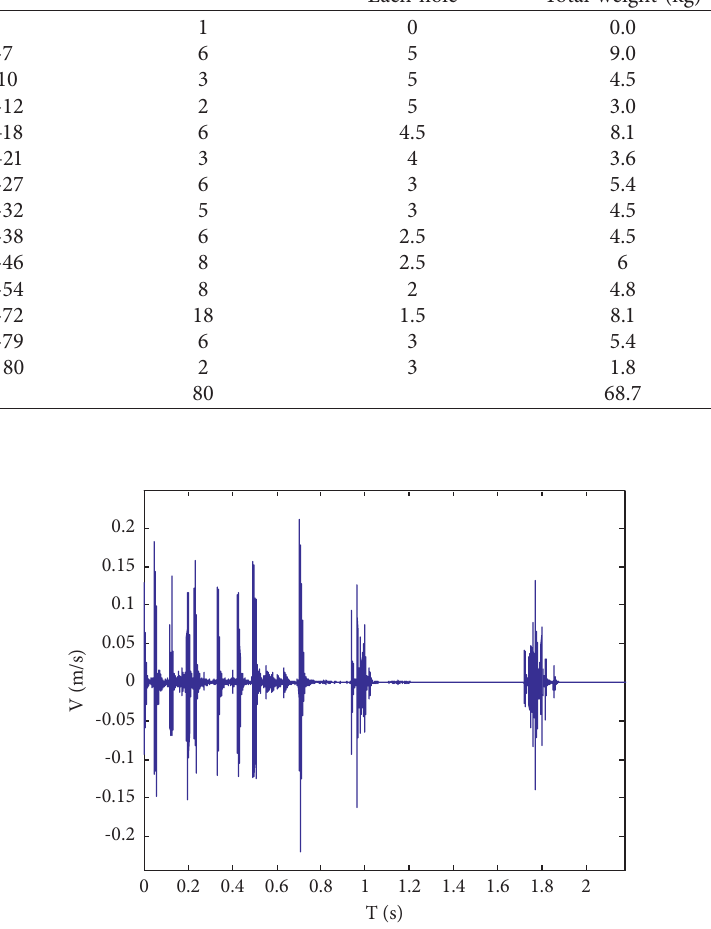
Figure 2: Typical blasting vibration waveform